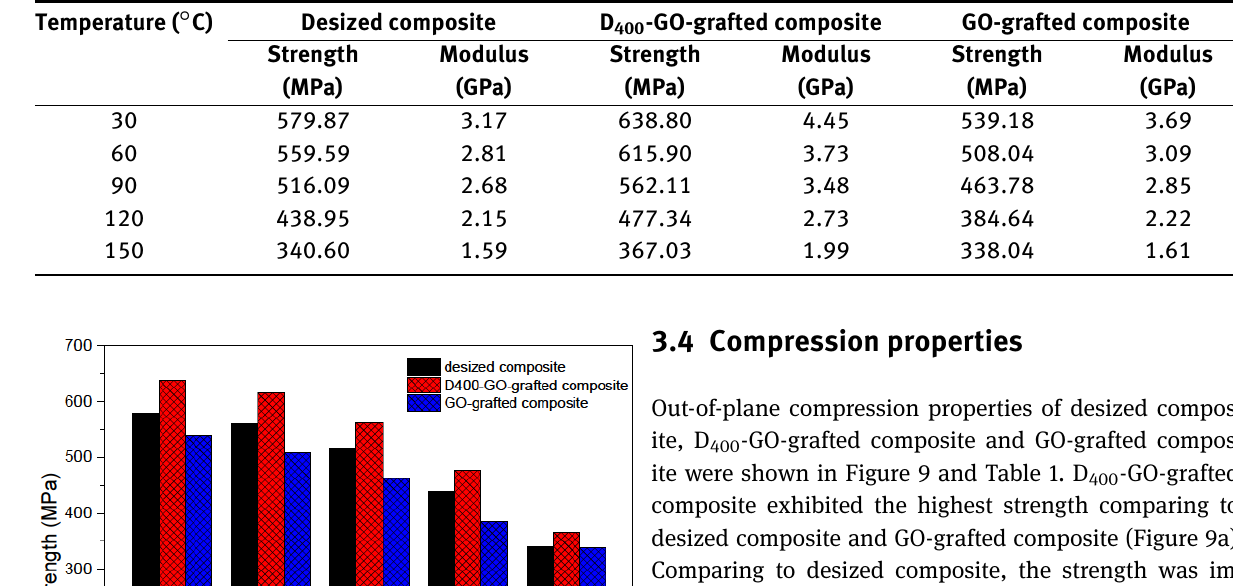
Table 1: Out-of-plane compression strength and modulus of composites